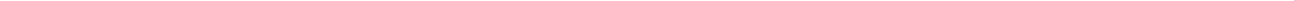
Fig. 5 Single-cell metrics comparing QD coatings and cell types. a Data for each QD coating show f 1 , f mobile , and f 1,mobile . The green dashed line in a , d – g , k , l indicates the lower limit of f mobile (0.053). Horizontal black lines indicate p < 0.05, calculated using Student ’ s t test, for f 1,mobile comparisons. b Number of internalized QDs per cell for 40 nM loading concentrations. For mPEG and pCOOH, data are linear extrapolations from 10 nM concentrations due to high spot intensity due to clustering. c Mobile QDs per cell. d Negative correlation between f mobile and N cell for coatings demonstrates that materials with high mobile fractions deliver less ef fi ciently. e Negative correlation between f mobile and n demonstrates that QDs are clustered in cells in which they are QD immobile. Coatings are indicated by color codes in d . Additional n QD distribution weightings are in Supplementary Figs. 12 and 13. f Comparison of f 1,mobile / f 1 and f >1,mobile / f >1 re fl ect the mobility for single QDs and clusters, respectively. Horizontal lines indicate p < 0.05 within coating types only. For QD coating comparisons, n = 7, 7, 16, 11, and 18 cells for mPEG, aCOOH, pCOOH, pPEG, and pZW, respectively. g Data for three cell types (A431, CHO-K1, and HeLa), showing f 1 , f mobile , and f 1,mobile . For A431 cells, single and clumped cells were analyzed separately. Horizontal lines indicate p < 0.05 for f 1,mobile . h Number of internalized QDs per cell. i Mobile QDs per cell. j N cell correlates with the average cell area. k Little correlation is observed between f mobile and n , but QD different cell types have distinct degrees of clustering. Cell types are indicated by color codes in j . l Comparison of f 1,mobile / f 1 and f >1,mobile / f >1 re fl ect the mobility for single QDs and clusters, respectively. Horizontal lines indicate p < 0.05 within cell types only. All cell-type comparisons used pPEG-QDs, with n = 10, 9, 7, and 9 cells for CHO, HeLa, single A431, and clumped A431 cells, respectively. All error bars are s.e.m. Comprehensive p values are